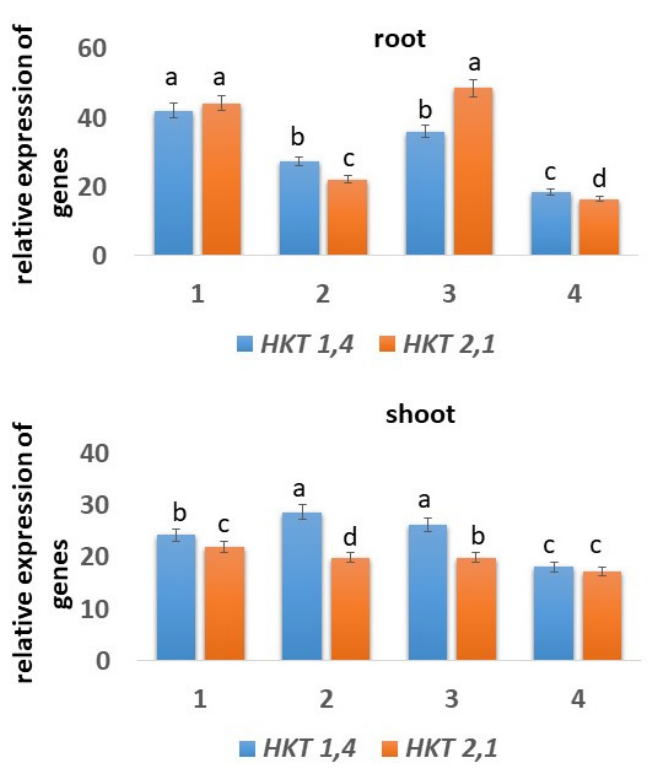
Figure 2. Expression of genes HKT in root and shoot of wheat Orenburgskaya 22 (1, 3) and Zolotaya (2, 4) grown in control condition (1, 2) and in presence of 150 mM NaCl. Bar represent standard deviation, p < 0.05. Different letters indicate significant differences at p < 0.05.